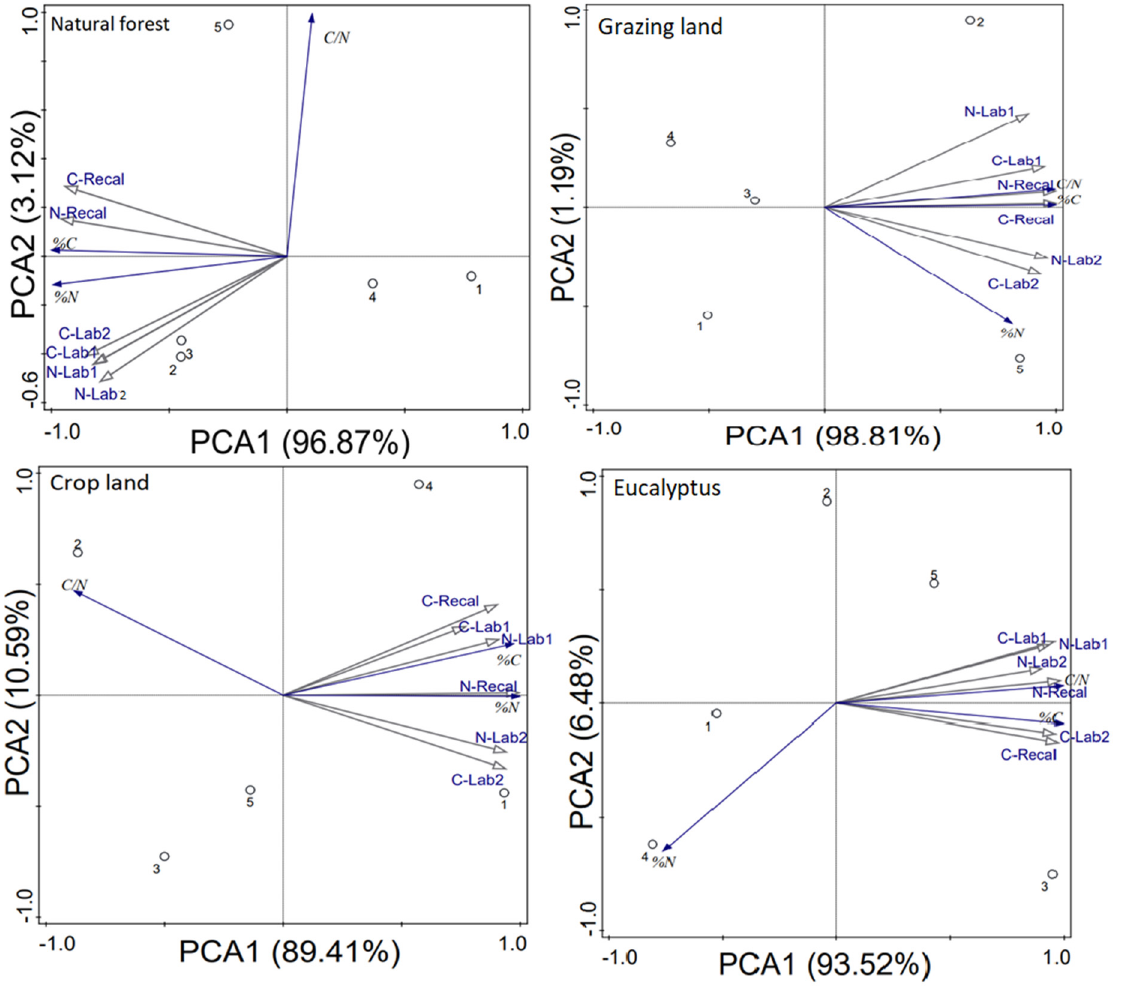
Figure 5. Principal component analysis (PCA) using soil C and N concentrations (% C & % N), C:N ratio, labile C and N (C-Lab1 & C-Lab 2, N-Lab 1 & N-Lab2) and recalcitrant C and N fractions (C-Recal & N-Recal). Each variable is represented by an arrow and showing the correlations between variables. In all four land-use types, two principle components (PCA1 & PCA2) explained all of the variances